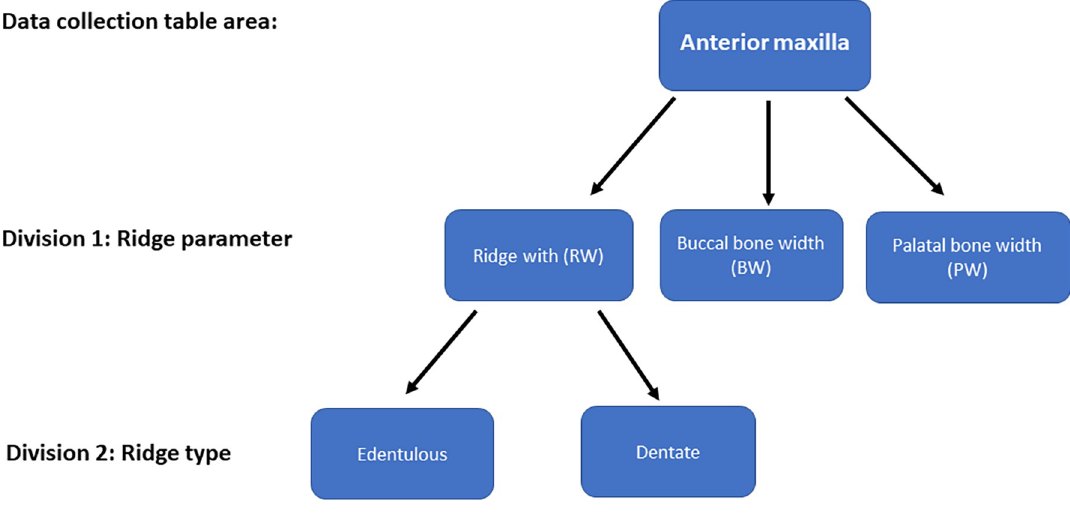
Fig 1. Elaboration process